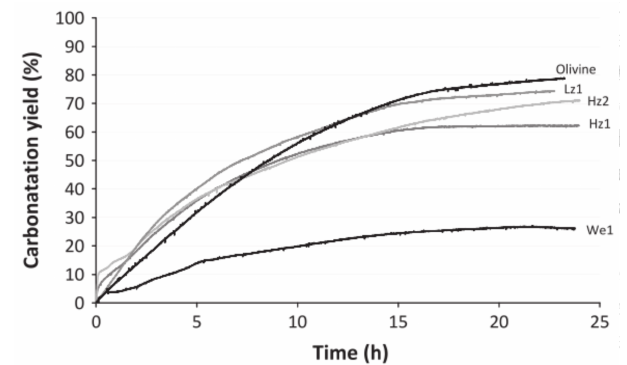
Figure 4. Kinetics of carbonation of various partially-serpentinized olivine as a function of time (T = 180 ◦ C, PCO 2 = 2 MPa, 90 g/L) with a continuous passivation layer exfoliation scheme. Hz